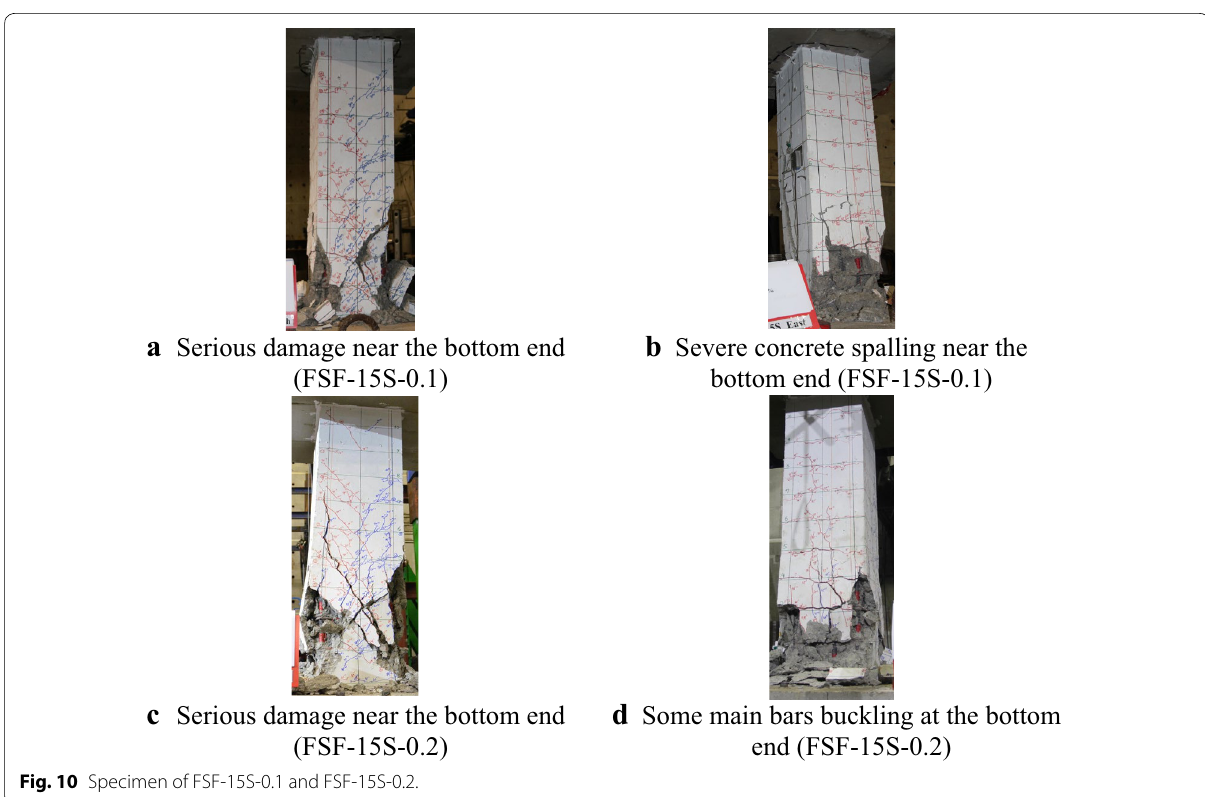
Fig. 10 Specimen of FSF‑15S‑0.1 and